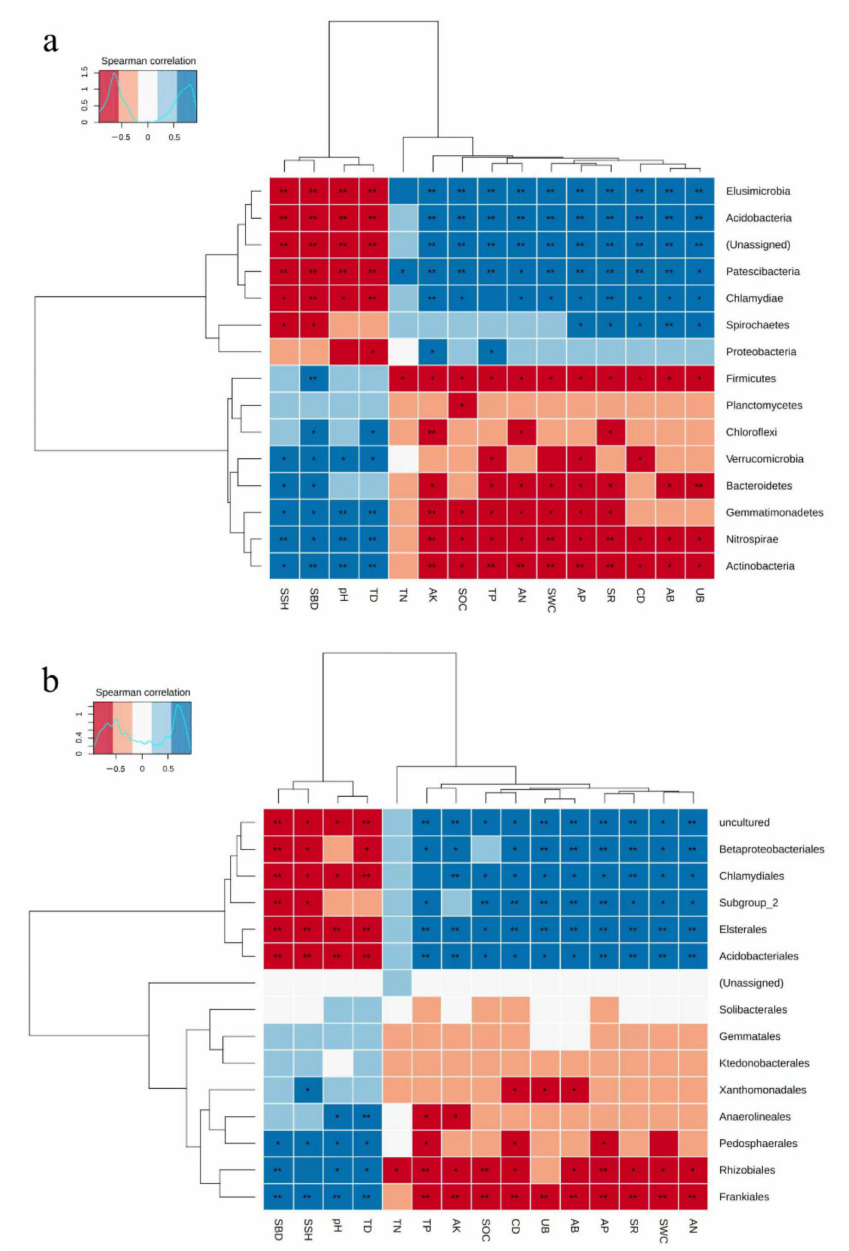
Figure 9. Spearman correlation analysis of phylum ( a ) and order ( b ) levels and environmental factors. Note: * p < 0.05 under diverse treatments. ** p < 0.01 under diverse